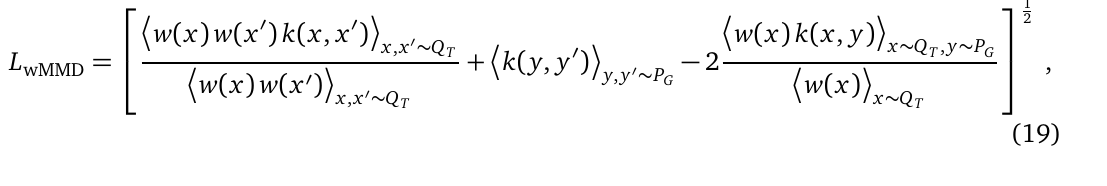
Table 1: Details for our uwGAN setup for the Drell-Yan